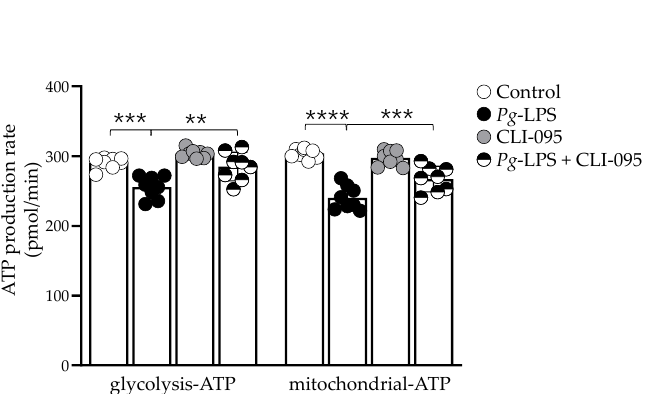
Figure 5. Mitochondrial functional analysis of OCR, ECAR and total ATP. ( A ) The basal respiration, maximum respiration, and spare respiratory capacity were increased with the treatment. ( B ) ECAR, basal and compensatory glycolysis were determined ( C ) Total ATP production was reduced with the treatment. CLI-095 (1 µ M) was used to recover the OCR, ECAR, and ATP ( n = 8). ** p < 0.01, *** p < 0.001, **** p < 0.0001.